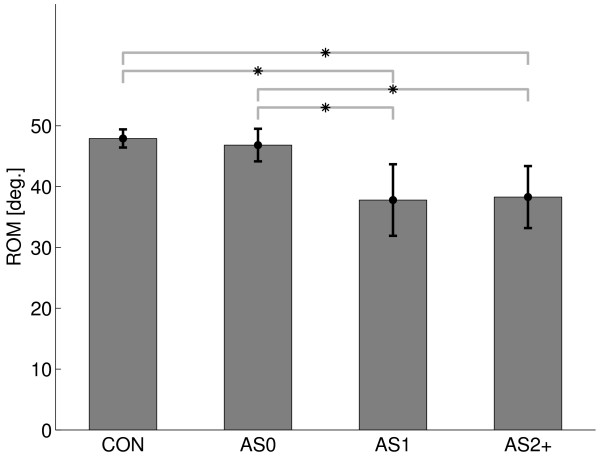
Range of motion. Range of motion (RoM) of all subject groups (mean and standard deviation). The asterisk denotes significant difference (see Results).